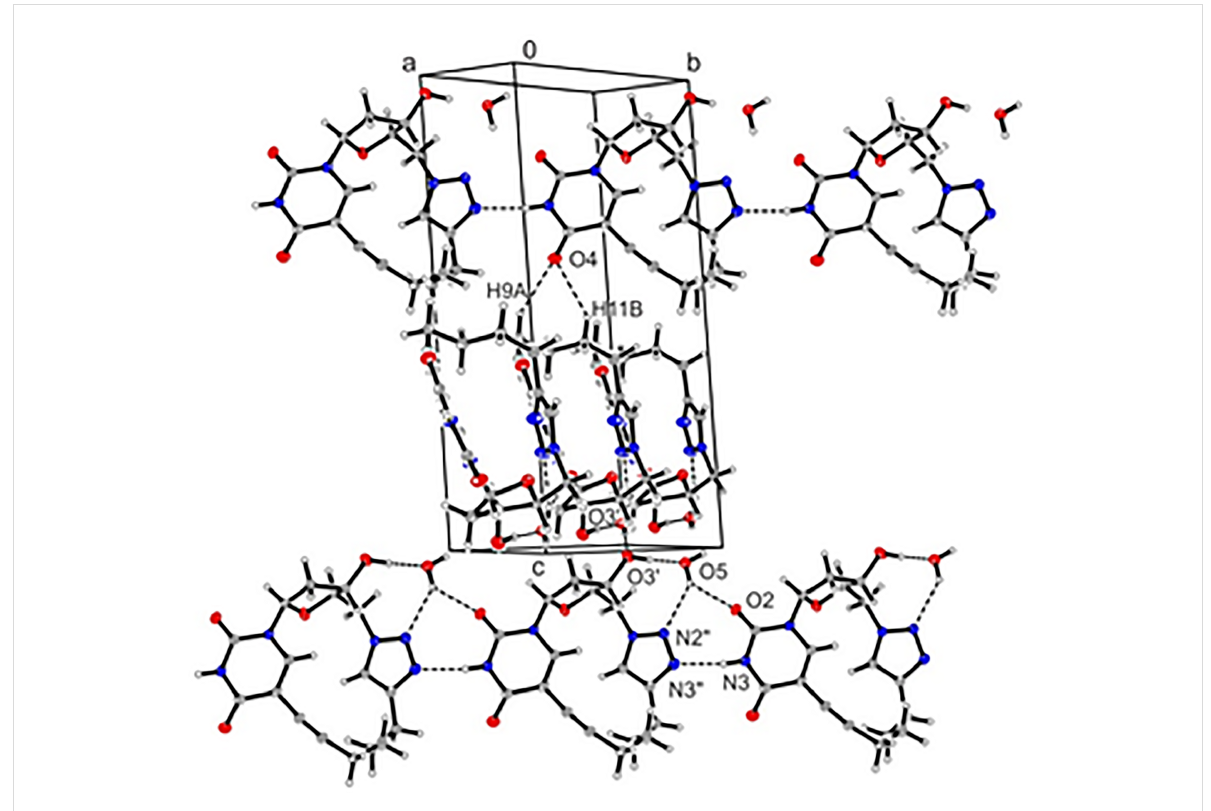
Figure 3: The crystal packing of 8 shows the intramolecular hydrogen-bonding network (projection parallel to the x-axis).